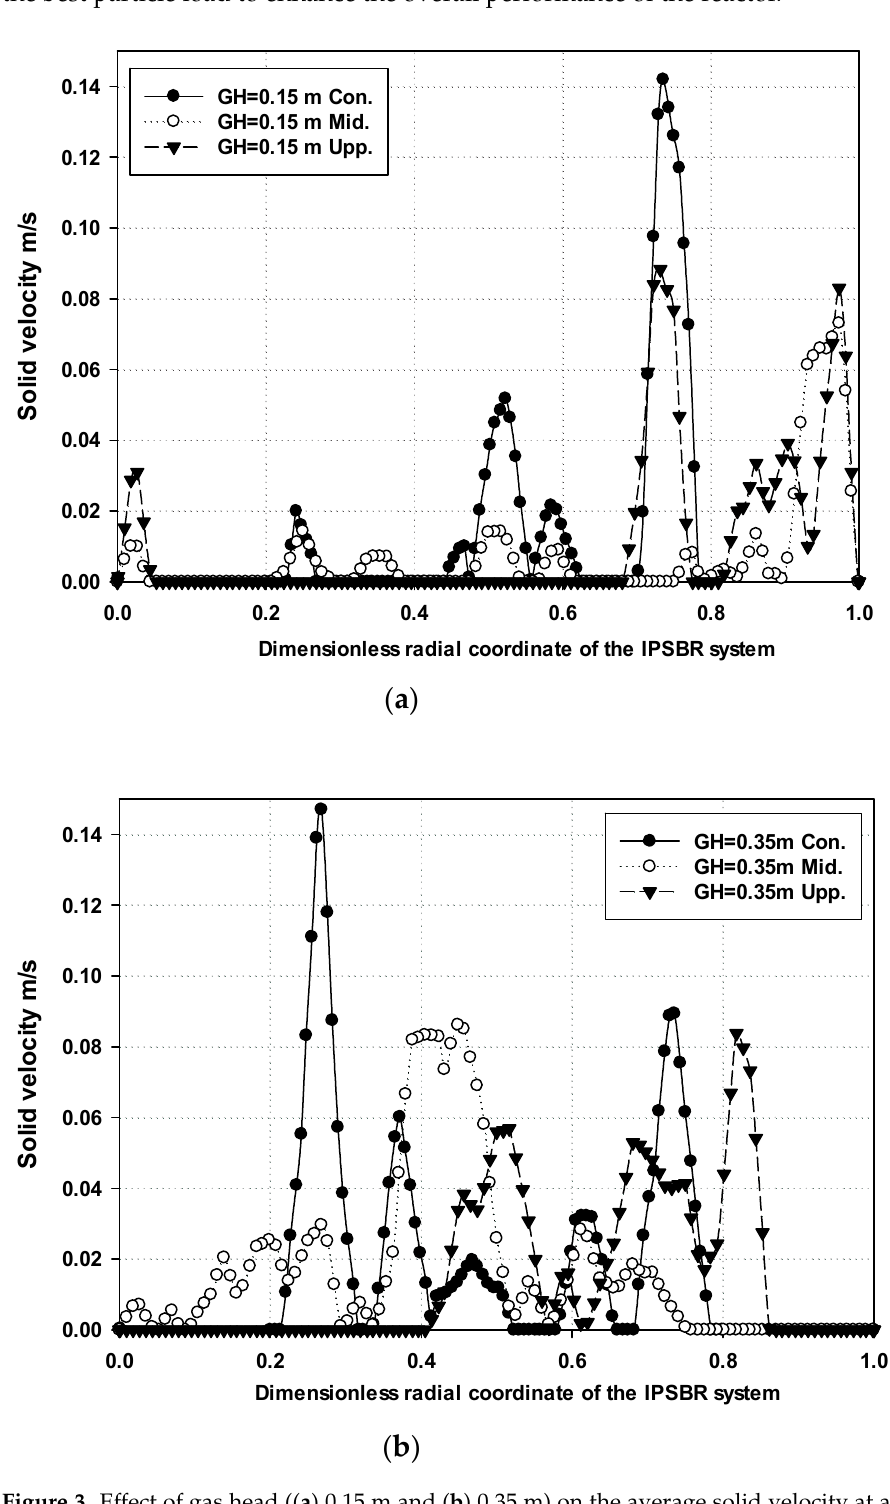
Figure 3. Effect of gas head (( a ) 0.15 m and ( b ) 0.35 m) on the average solid velocity at a constant feed gas velocity of 1 m/s, orifice diameter of 0.003 m, mixing particle diameter of 0.0135 m, and total mass of mixing particle of 0.06 kg in the conical, middle, and upper regions. (d) Effect of mixing particle diameter on average solid velocity The influence of the mixing particles diameter of 0.0135 and 0.0225 m at a constant feed gas velocity of 1 m/s, 0.003 m orifice diameter, gas head of 0.25 m, total mass of mix- ing particle of 0.06 kg on the average solid velocity in all three regions is illustrated in Figure S2a,b. It was observed that at high mixing particles diameter (0.0225 m), some of the particles settled in the conical section of the reactor and show zero velocity. It was also found that by increasing the size of the mixing particles, their velocity decreased remark- ably in the middle and upper regions. As illustrated in Figure S2b, the maximum particle velocity reached was approximately 0.037 m/s in the upper region, which is still a rela- tively low value. Decreasing the particles diameter as shown in Figure S2a resulted in an increase in the solids velocity as detected in the conical region.